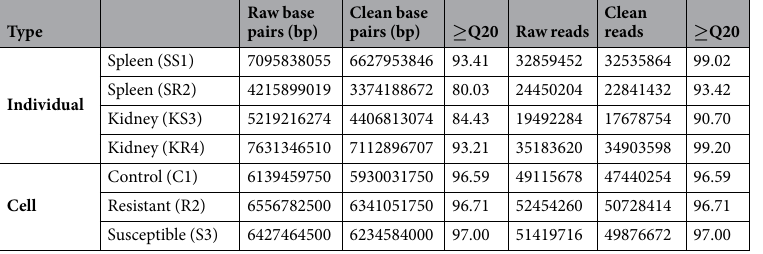
Table 1. Summary of the transcriptomes of C. idella in individuals and cell lines. Note: Paired-end reads were generated in lengths of 2 × 250 bp and 2 × 125 bp in individuals and CIK cells by Illumina MiSeq and HiSeq2500, respectively. SS1 and SR2 represent susceptible and resistant spleen tissues, respectively. KS3 and KR4 represent susceptible and resistant head-kidney tissues, respectively. C1, R2 and S3 represent control, resistant and susceptible groups in cells, respectively. Q20: percentage is the proportion of nucleotides with a quality value ≥ 20 in